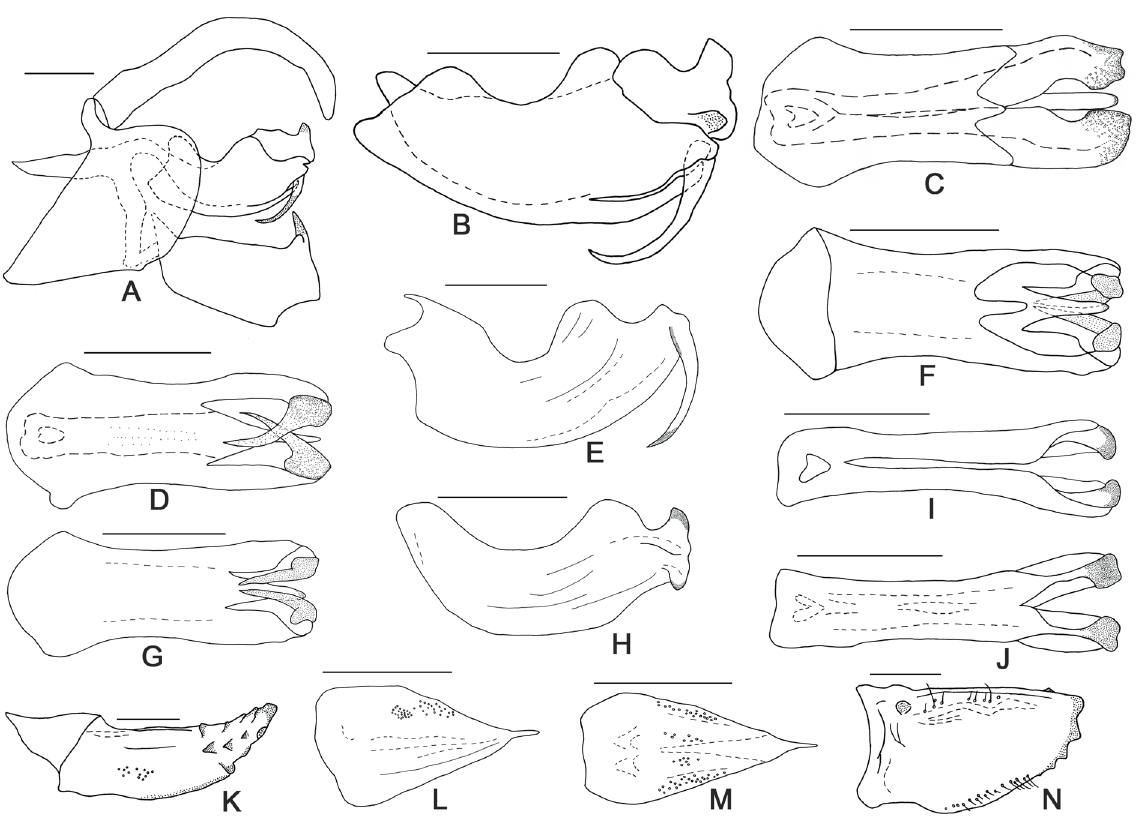
VIII, right lateral outside view. L . Gonapophysis IX, lateral view. M . Gonapophysis IX, dorsal view. N . Gonoplac, right lateral outside view. Scale bars = 0.5